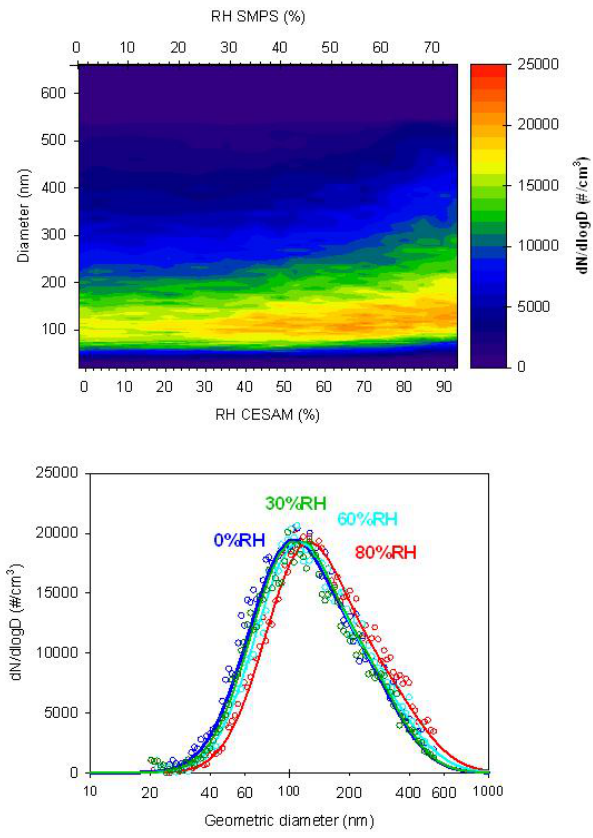
Fig. 8. Number size distribution of ammonium sulfate particles for increasing RH during humidification in the chamber in the experi- ment E1212.